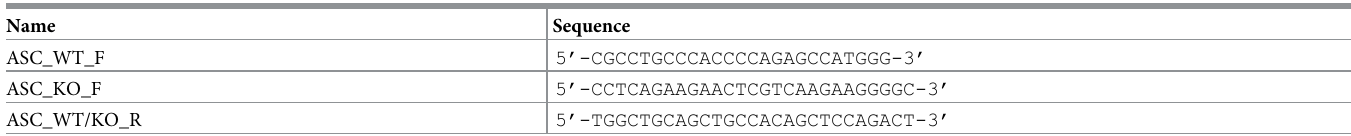
Table 1. Primers used for